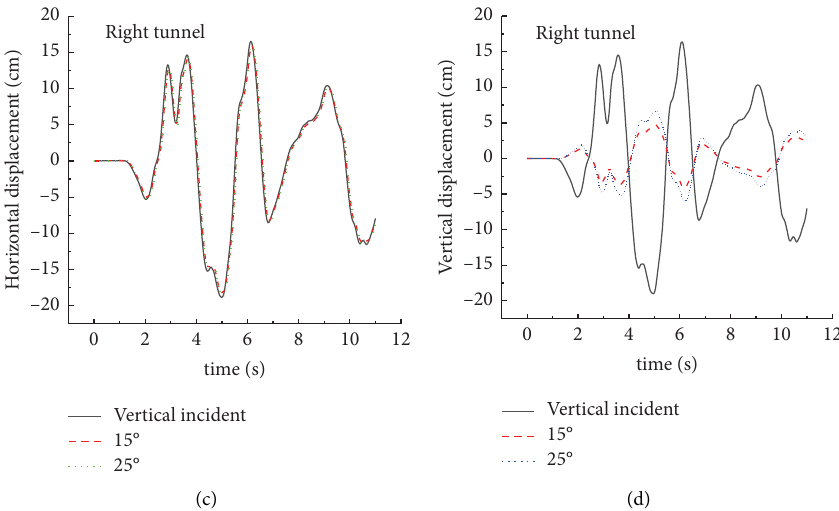
Figure 8: Comparison of the displacement of the left and right tunnels: (a) horizontal displacement of point A in the left tunnel, (b) vertical displacement of point A in the left tunnel, (c) horizontal displacement of the right tunnel A ′ point, and (d) vertical displacement of the right tunnel A ′